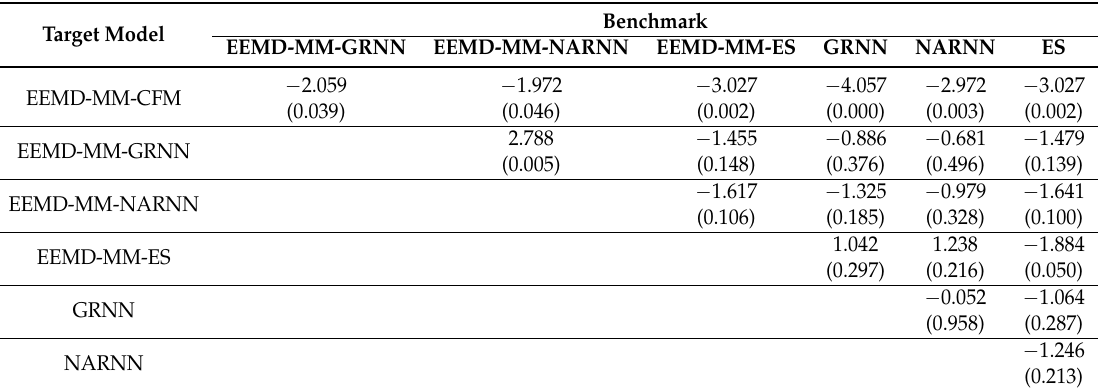
Table 3. DM test results across different